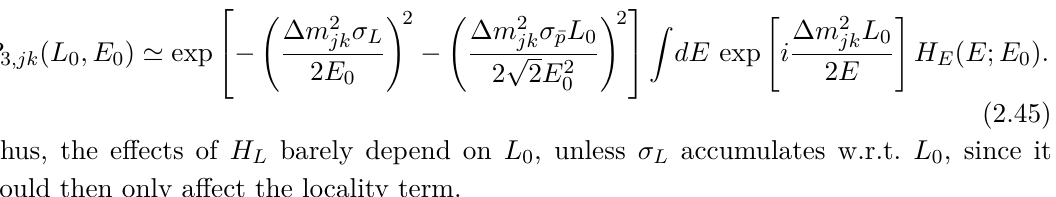
at near detectors while effects of σ L